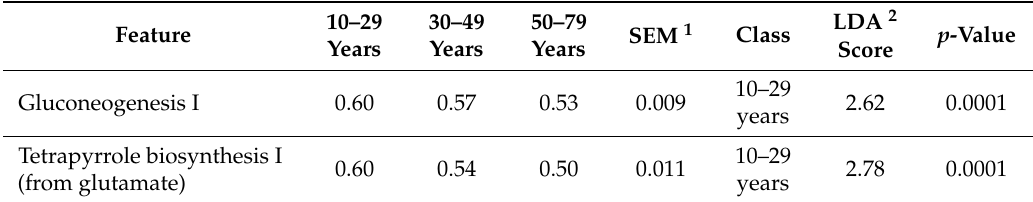
Figure 5. Functional distribution of Kyoto Encyclopedia of Genes and Genomes (KEGG) orthologs on the ( a ) forehead skin and ( b ) hand skin among age groups. Non-parametric Permutational